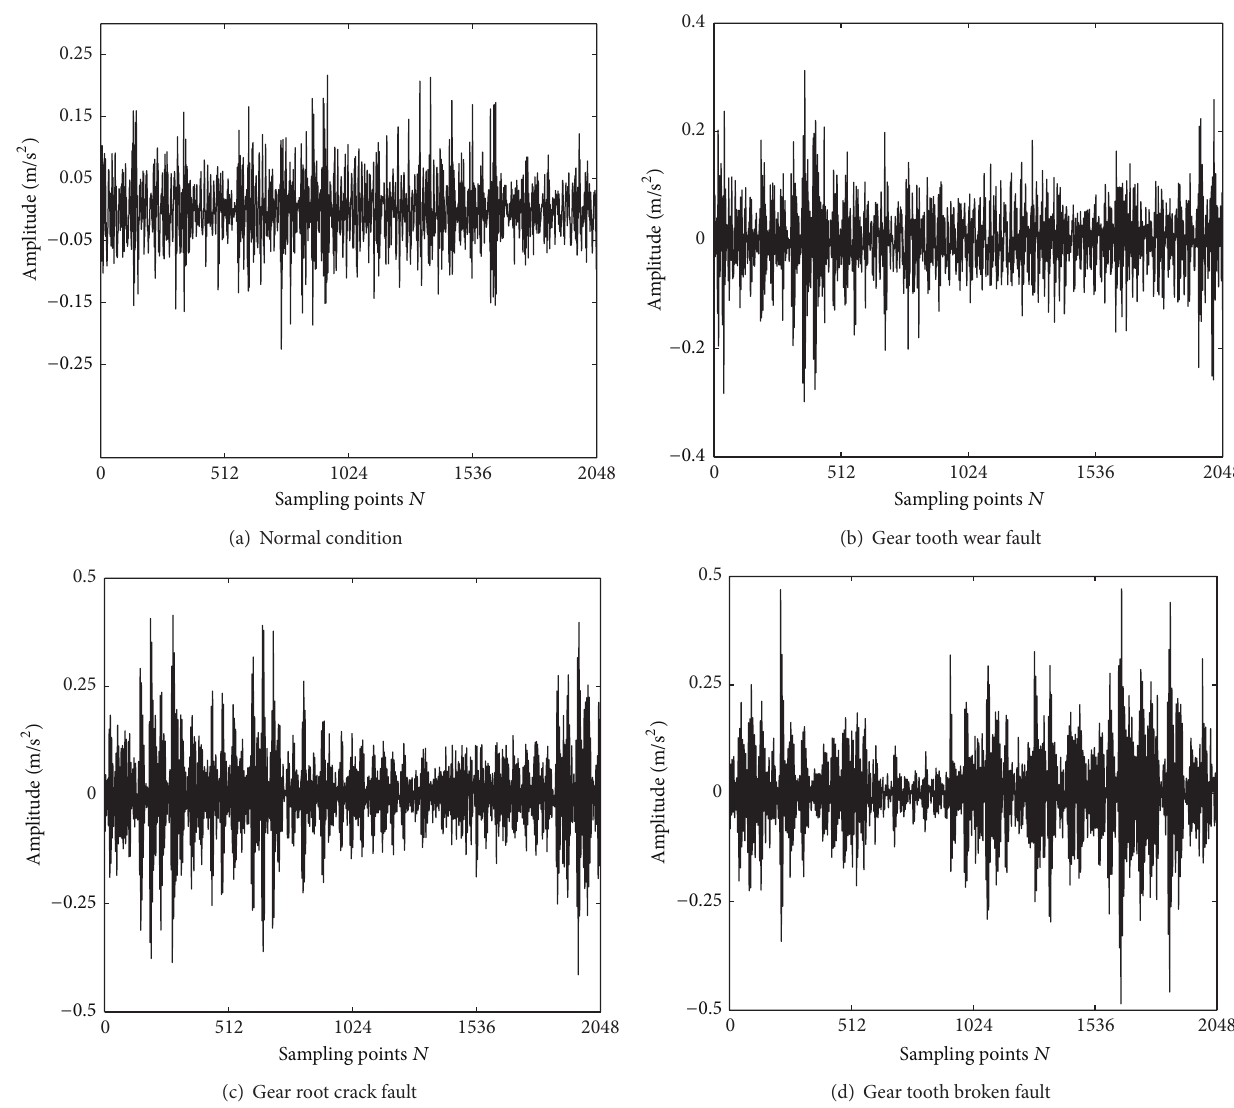
Figure 5: The quantum circuit of